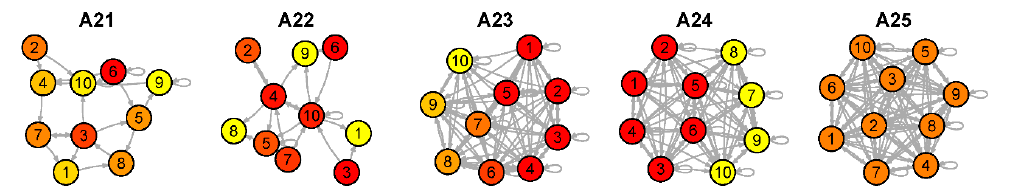
Figure A3. Graphs G ( i ) with closeness centralities colored by the yellow-red gradient. Figure 3. Graphs G ((cid:3036)) with closeness centralities colored by the yellow-red gradient.